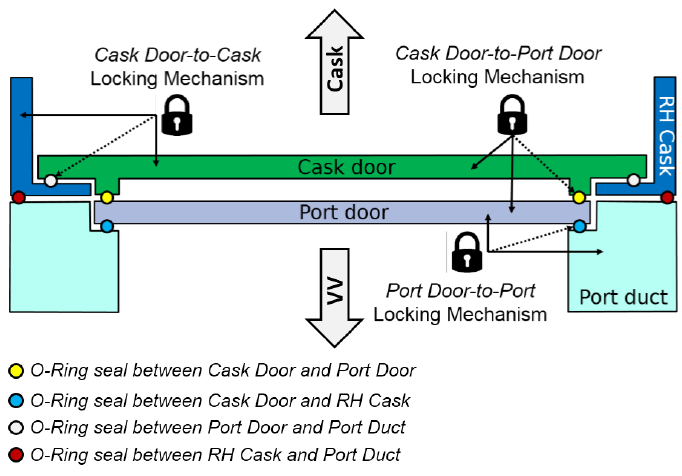
Figure 3. Schematic diagram of the CCD and its relevant subsystems